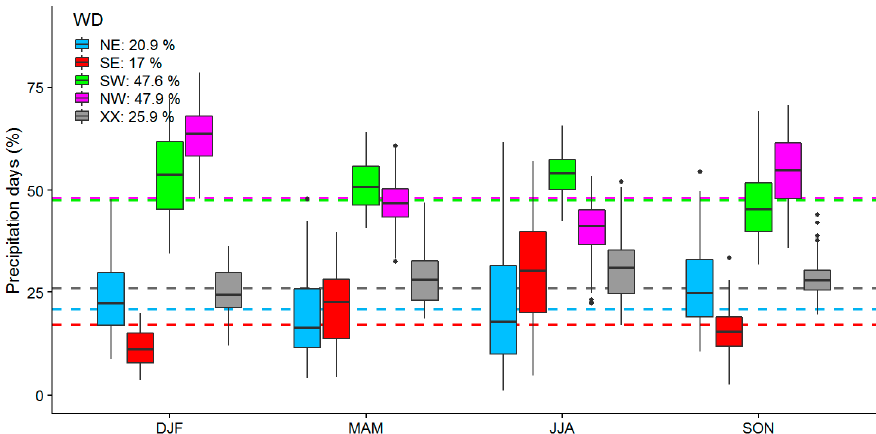
Figure 5. Percentage of wet days per wind direction (WD) in different seasons. The boxplots represent the distribution of this percentage across all stations. The horizontal colored lines and associated numbers in the legend represent the mean percentage across all years and stations, regardless of season. For the WD classes, see Section 2.1. In each boxplot, outliers are represented by black dots, the median is represented by the horizontal thick line, and the lower and upper hinges represent the first and third quartiles, while the upper (lower) whisker extends from the upper (lower) hinge to the largest (smallest) value no further than 1.5 times the interquartile range from the hinge [57].